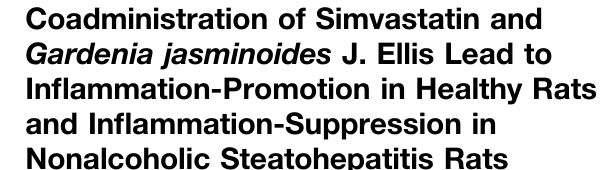
Frontiers in Pharmacology |